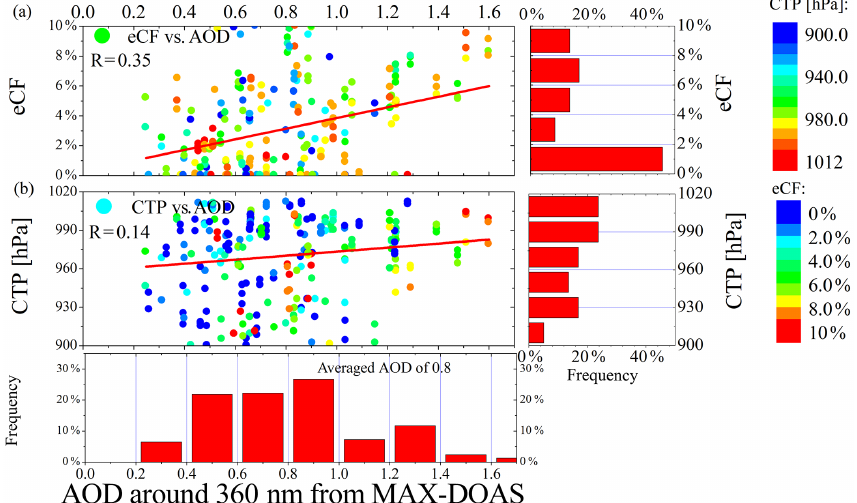
Figure 15. eCF and CTP from the OMI cloud algorithm for individual OMI observations are plotted against AOD at 360nm derived from MAX-DOAS observation (for eCF<10% and CTP>900hPa). The red bars on the right and bottom indicate the frequency of eCF, CTP and AOD in different value intervals. The red lines are the linear regressions of the scatter plots. The correlation coefficients are shown in the figure. The colour of the dots in (a) and (b) indicates CTP and eCF,